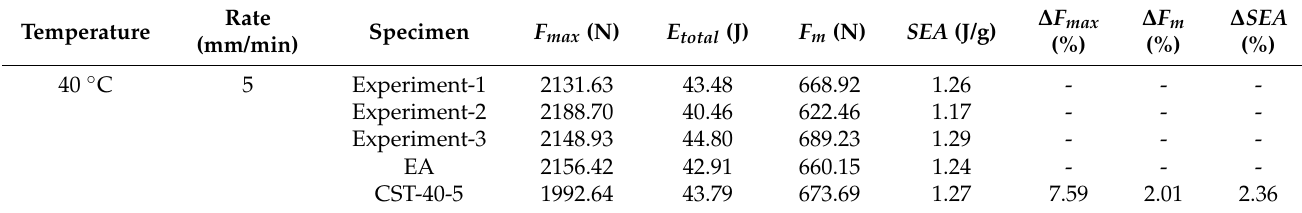
Table 2. Comparison of simulation results with experimental